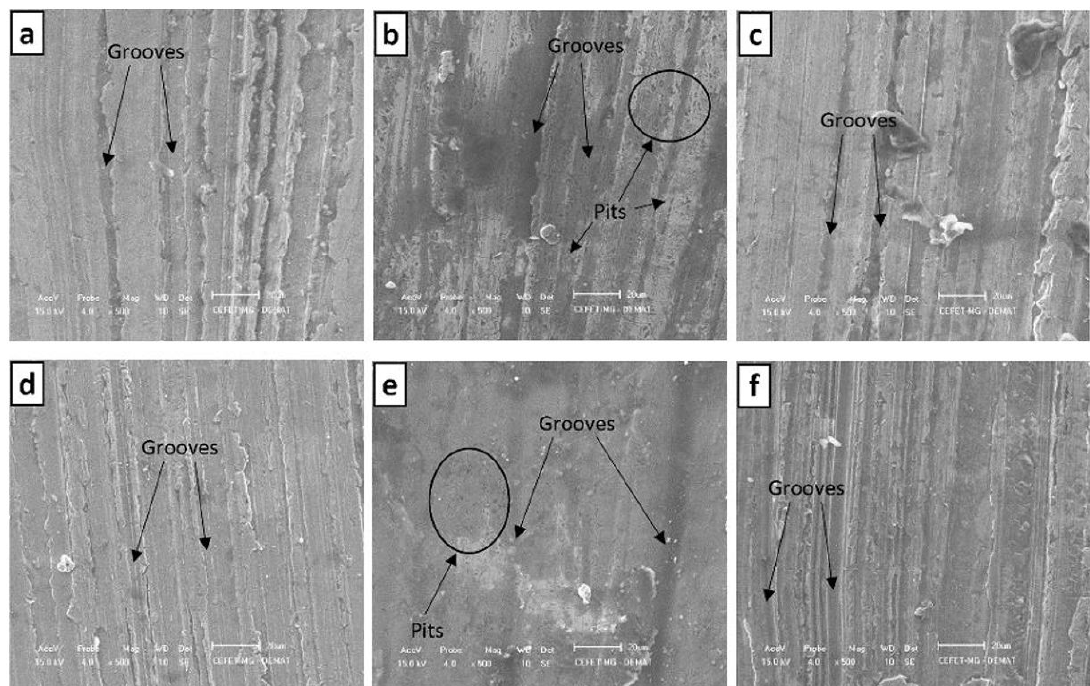
Figure 14. Scanning electron microscopy of the top view of the worn surfaces at 130N (upper line) and 45N (lower line): (a, d) HCCI0%Nb; (b, e) HCCI0.5%Nb; (c, f)